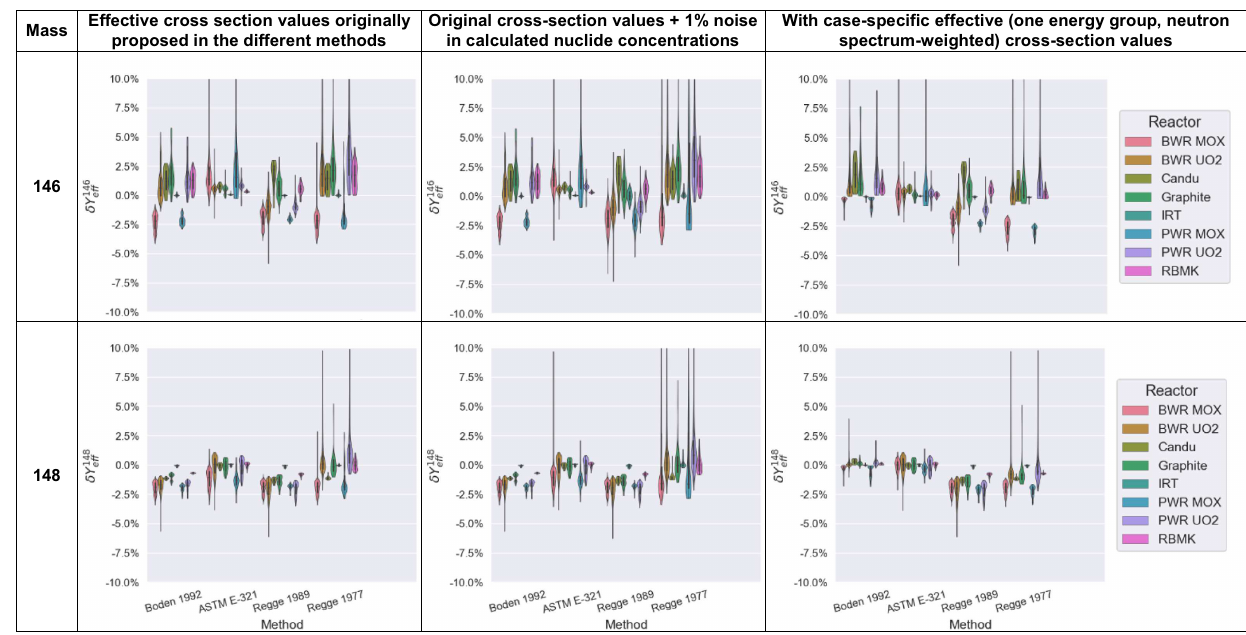
Fig. 2. Ratio of the irradiation-averaged fission yields predicted by the different burnup determination methods (from the calculated fuel inventories) to the simulation-based irradiation-averaged fission yields for mass series 146 and 148. The comparison provides an integral assessment of the distribution of fissions predicted by the different burnup determination methods. In the first column (“original”), the set of cross-section parameters as proposed in the individual articles [13,14,16,17] is used. The second column illustrates the sensitivity to experimental scatter, which is simulated by means of noise to the nuclide concentrations in the assessment database, assuming a normal distribution (1% standard deviation) around the calculated value. The last column illustrates the performance of the different methods when the case-specific effective cross-section values are used to calculate the irradiation-averaged fission yields.